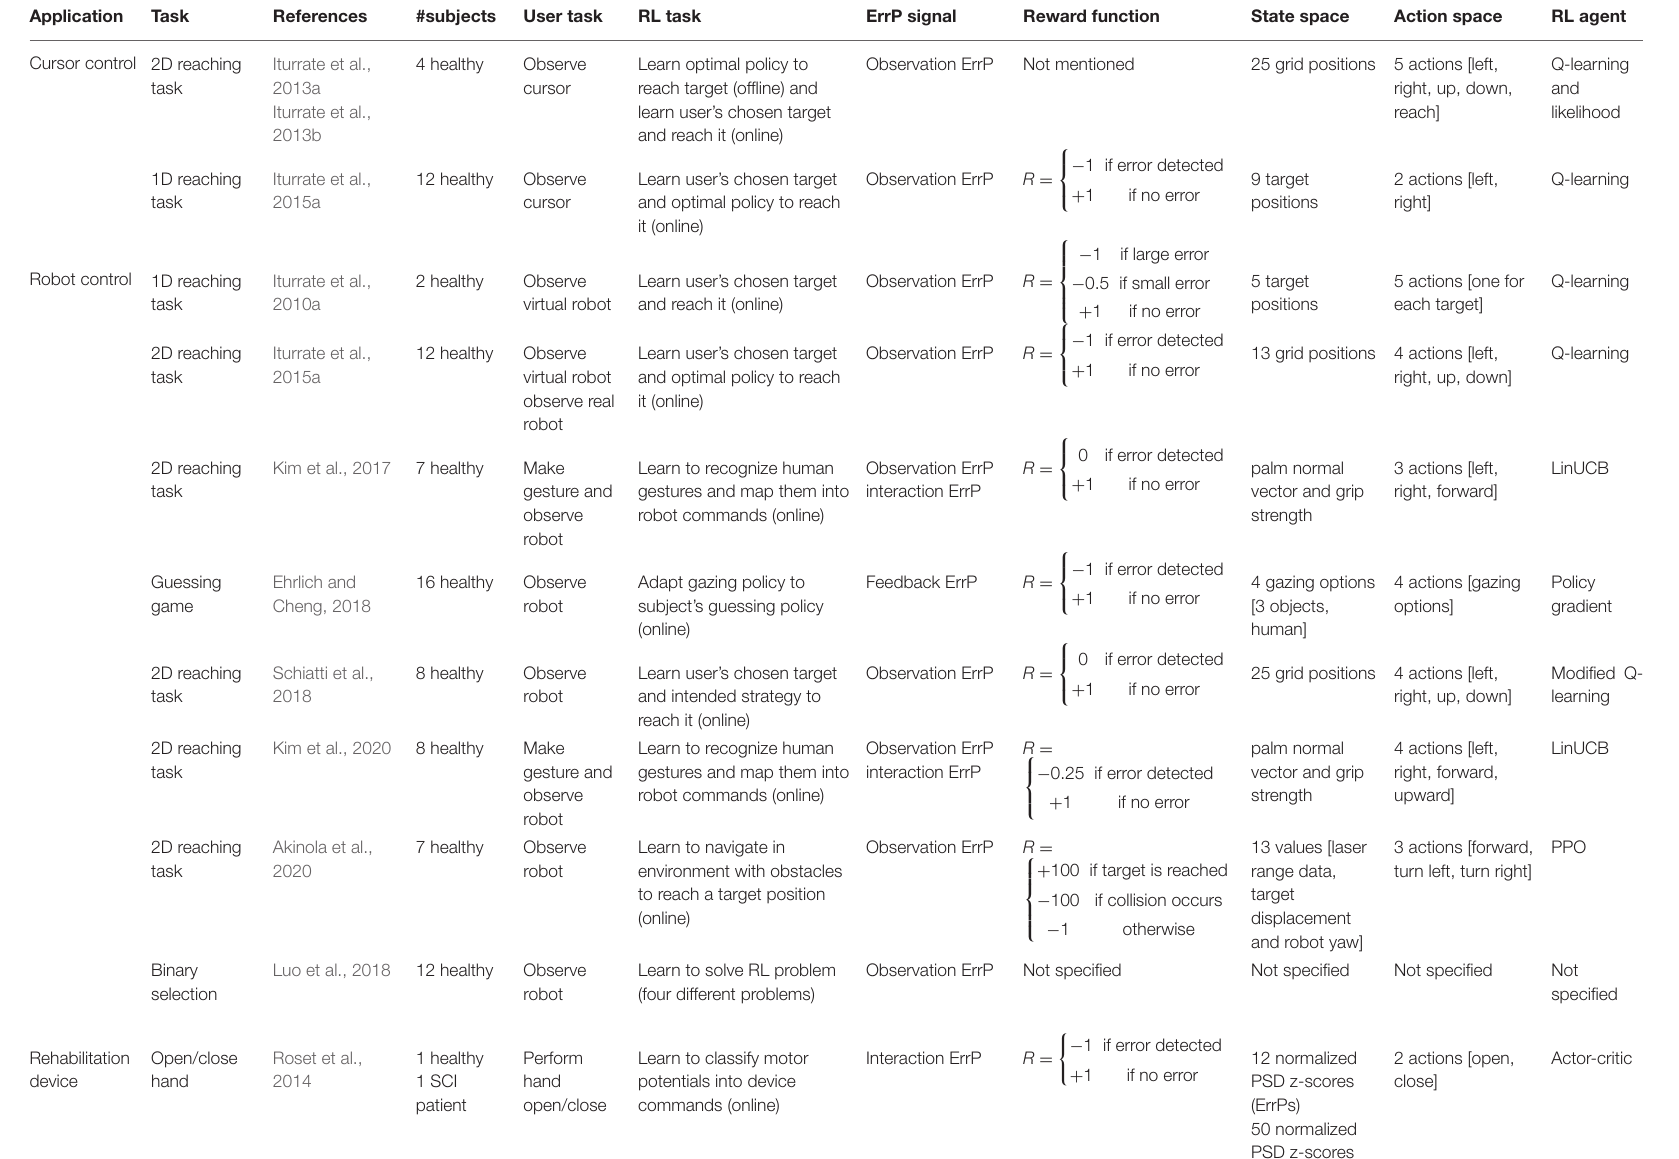
TABLE 3 | Overview of brain-machine interface systems that use error-related potential-based reinforcement learning frameworks.